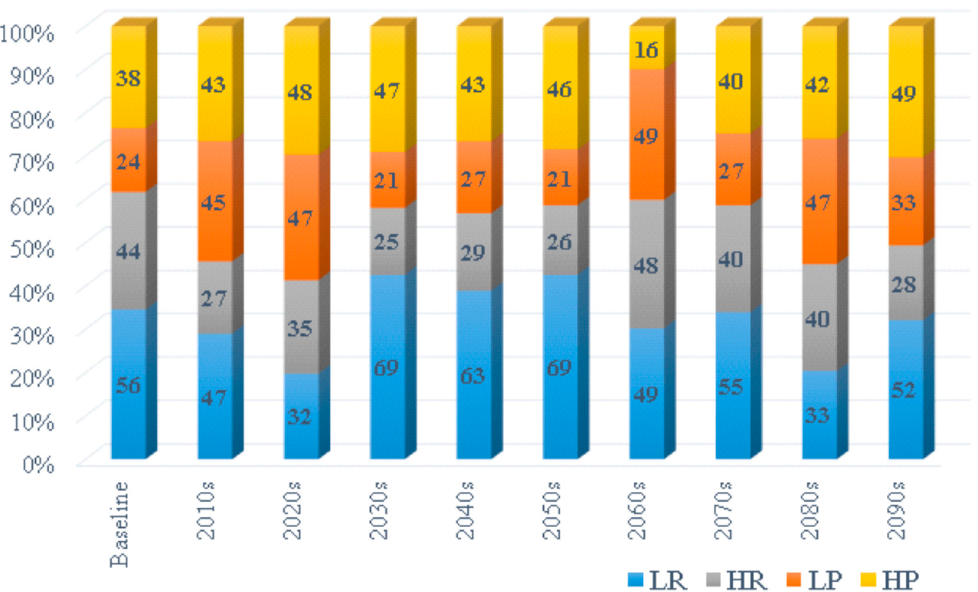
Figure 7. Regional distribution of sensitivity types for scenario RCP 4.5. Water-poor regions were highest in the 2020s and LR regions were highest in the 2030s and 2050s.